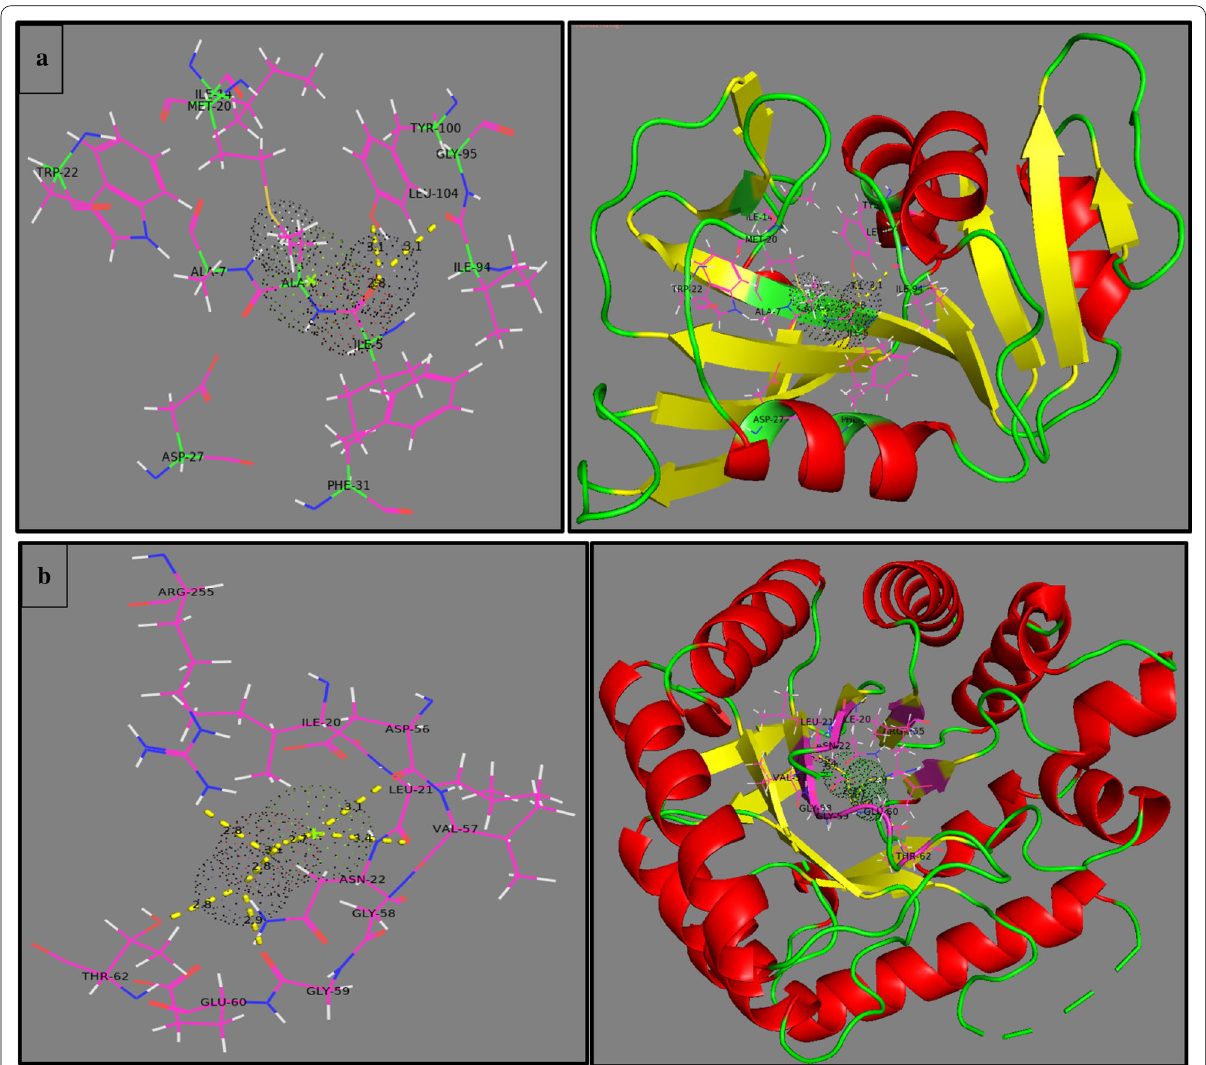
Fig. 11 Binding interaction pattern of Mg‑doped ZnO NRs inside active pocket a Dihydrofolate reductase (DHFR), b Dihydropteroate synthase (DHPS) from E.